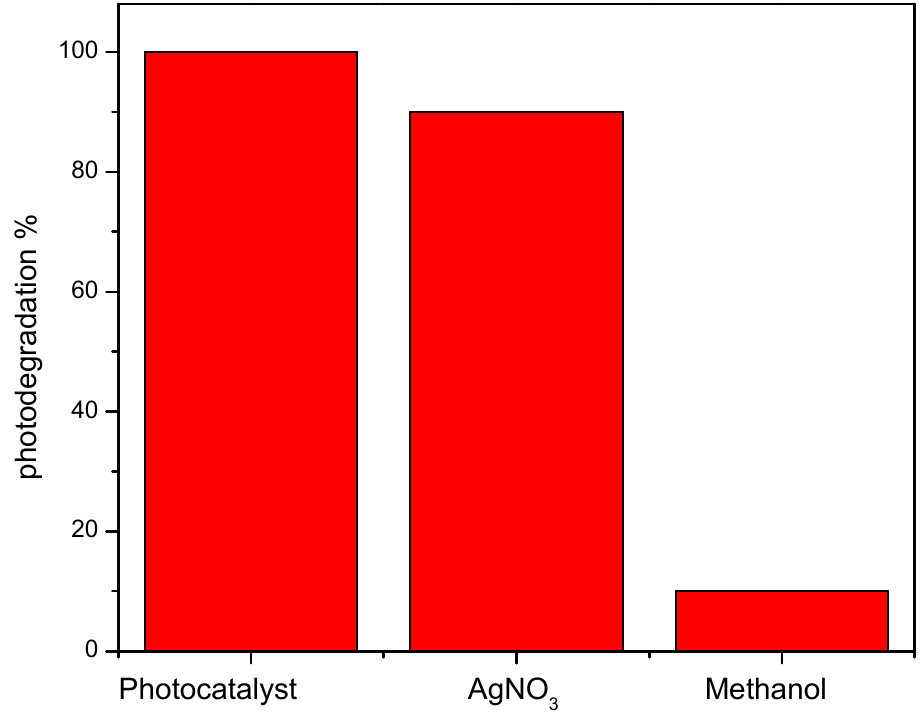
Figure 5. Charge carrier trapping experiment, AgNO 3 as electron scavenger and methanol as hole scavenger of Ag 9 (SiO 4 ) 2 NO 3 .